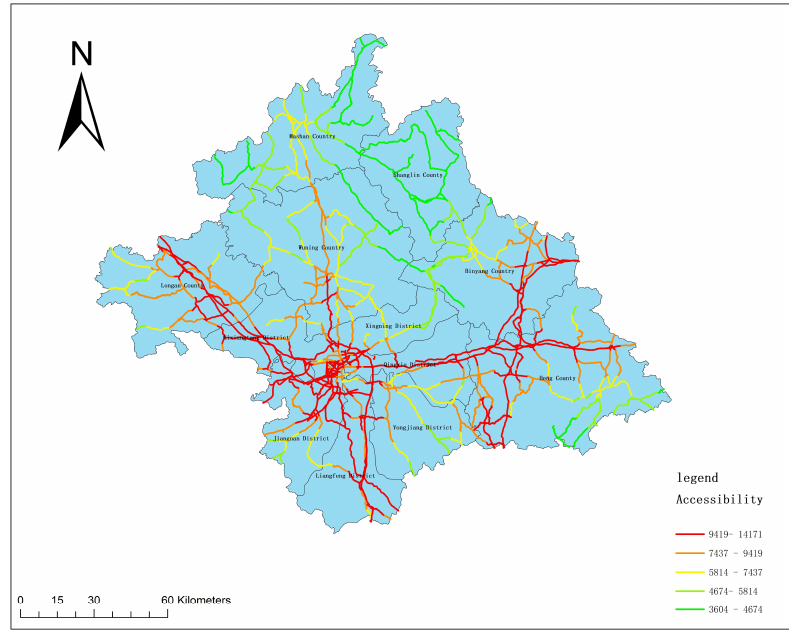
Figure 5. Road accessibility analysis of Nanning